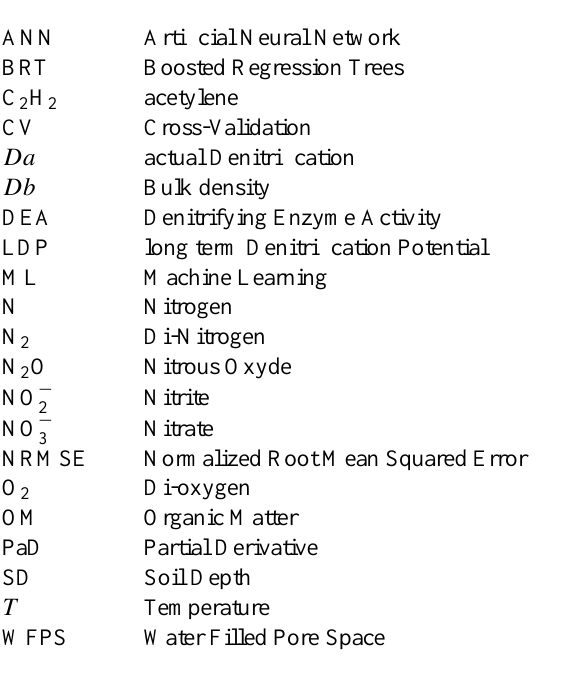
Figure D1 represents the scatterplots of the combination of Da , NO − , WFPS, OM, pH and T . These can be 3 used as guidelines to evaluate the domain of validity of the ANN5(OM,pH)G